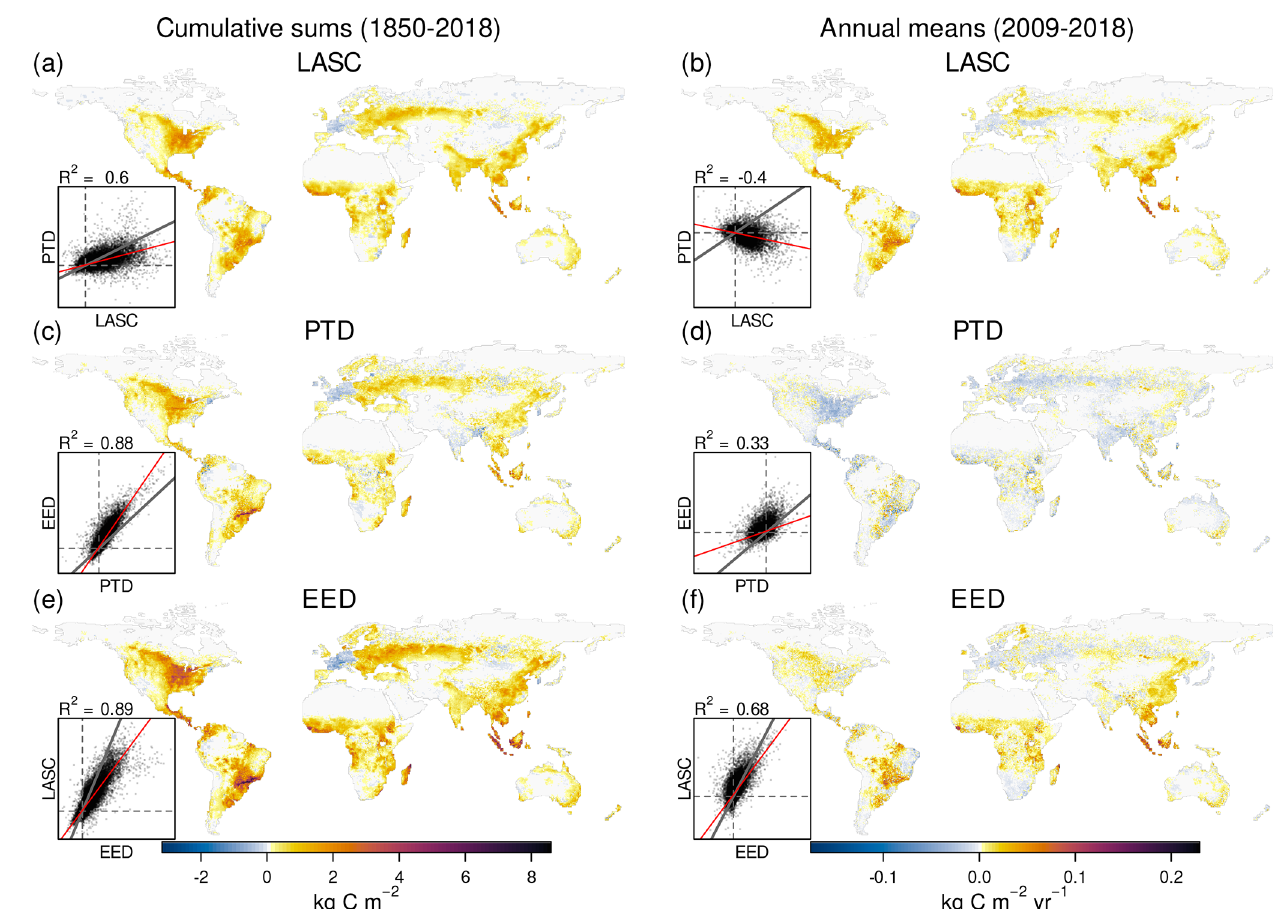
Figure 10. Cumulative sums from 1850 onward (a, c, e) and annual means for 2009–2018 (b, d, f) of the loss of additional sink capacity (LASC; a, b ), the “present-day” vs. “transient” environmental conditions difference (PTD; c, d ) and the environmental equilibrium difference (EED; e, f ) averaged across the models. Additionally, correlation plots between the different pixel-wise estimations are shown; here, the grey line represents the 1 : 1 line, the dashed grey lines depict zero lines, and the red line shows a fitted linear model. The EED and PTD were not derived for CLM5.0, JULES, LPJ, and OCN models (see Table